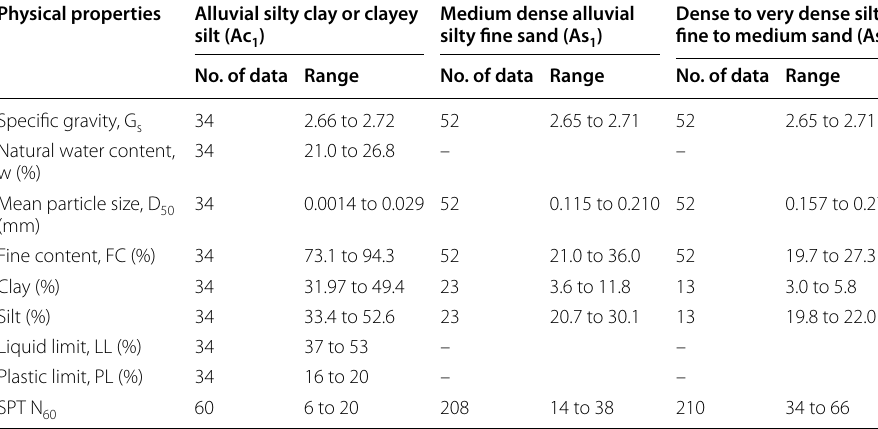
Table 3 Physical properties of soil layers Physical